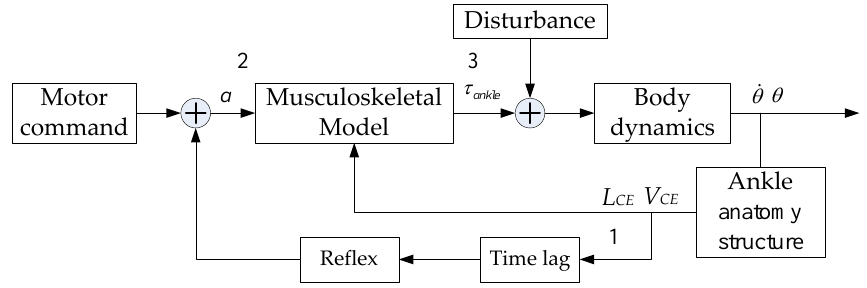
Figure 2. Ankle joint neural-muscular control model. Muscle fiber parameters L CE and V CE are converted from θ and 𝜃̇ via ‘Ankle anatomy structure’.